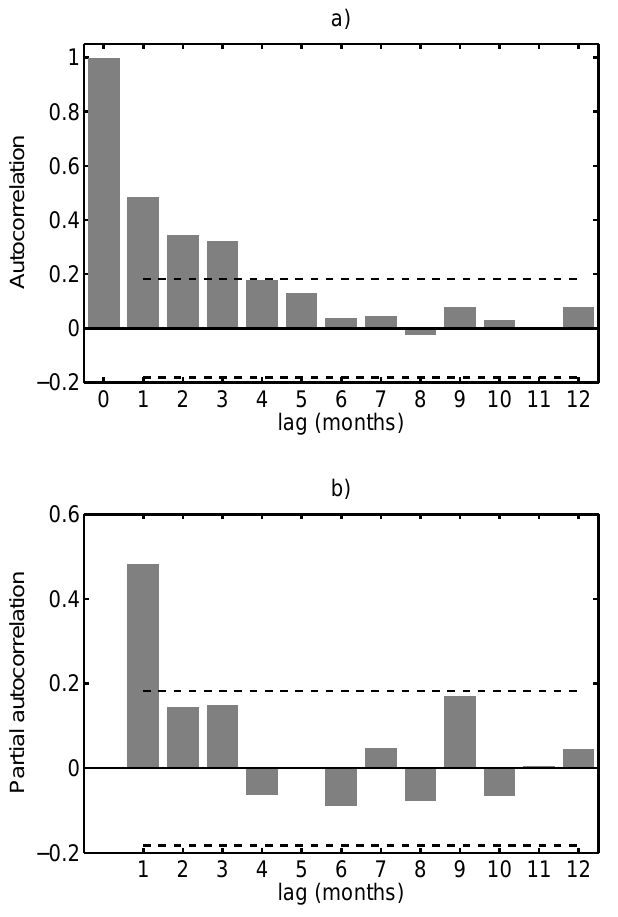
Fig. A2. (a) Sample autocorrelation function and (b) sample par- tial autocorrelation function of the SeaWiFS ocean global chloro- phyll monthly anomalies from 1998–2007. The dashed lines present the 95% confidence interval for the partial autocorrelation. The ex- ponential decay in the autocorrelation function and significance of only the lag 1 in the partial autocorrelation function indicates a first- order autoregressive process (red noise).